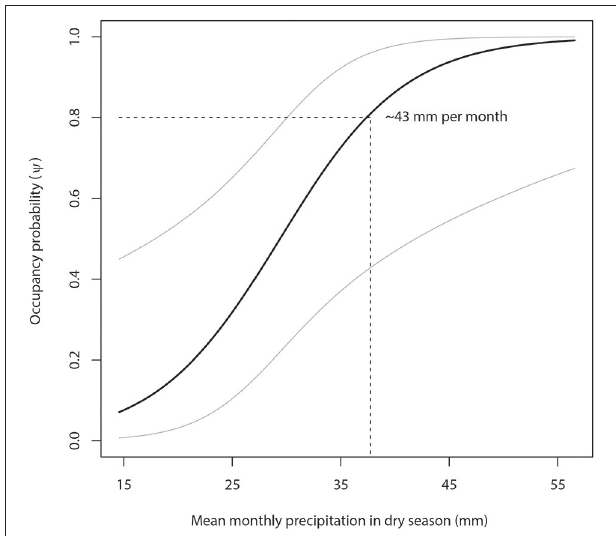
FIGURE 3 | Lion occupancy estimates in WAP (with 95% Prediction Intervals) given variation in number of permanent staff (USD/1000km 2 ). Our model predicts that areas with a minimum lion occupancy probability of 80% employs at least 9 staff members per 1000km 2 .